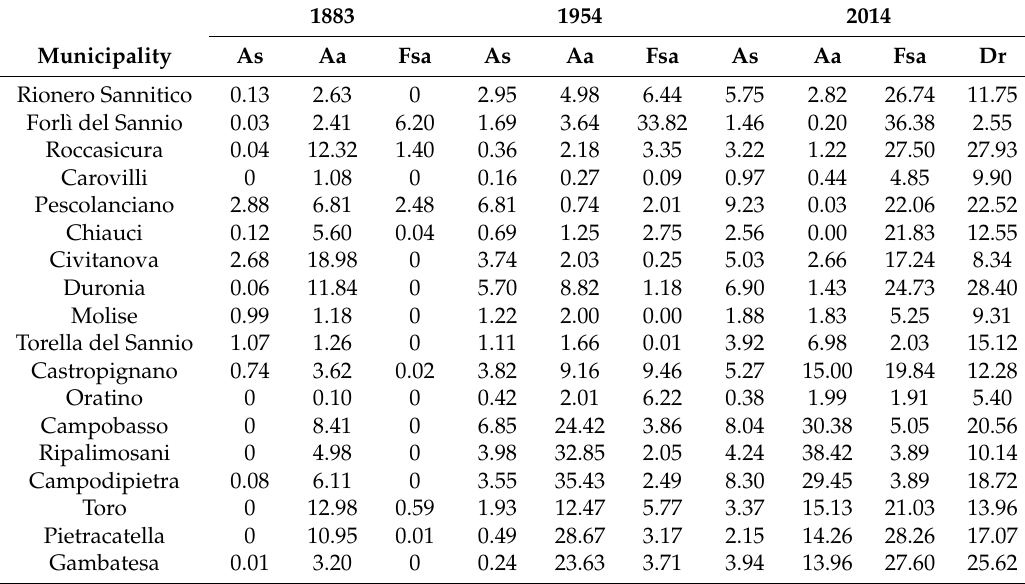
Table 5. Comparison, by municipality, of employment patterns, in hectares, among the Bonamici’s reinstatement (1883) and the maps made for 1954 and 2014. As: Artificial surfaces; Aa: Agricultural areas; Fsa: Forest and semi natural areas; Dr: Tratturo (drove road) in its preserved state (grassland).